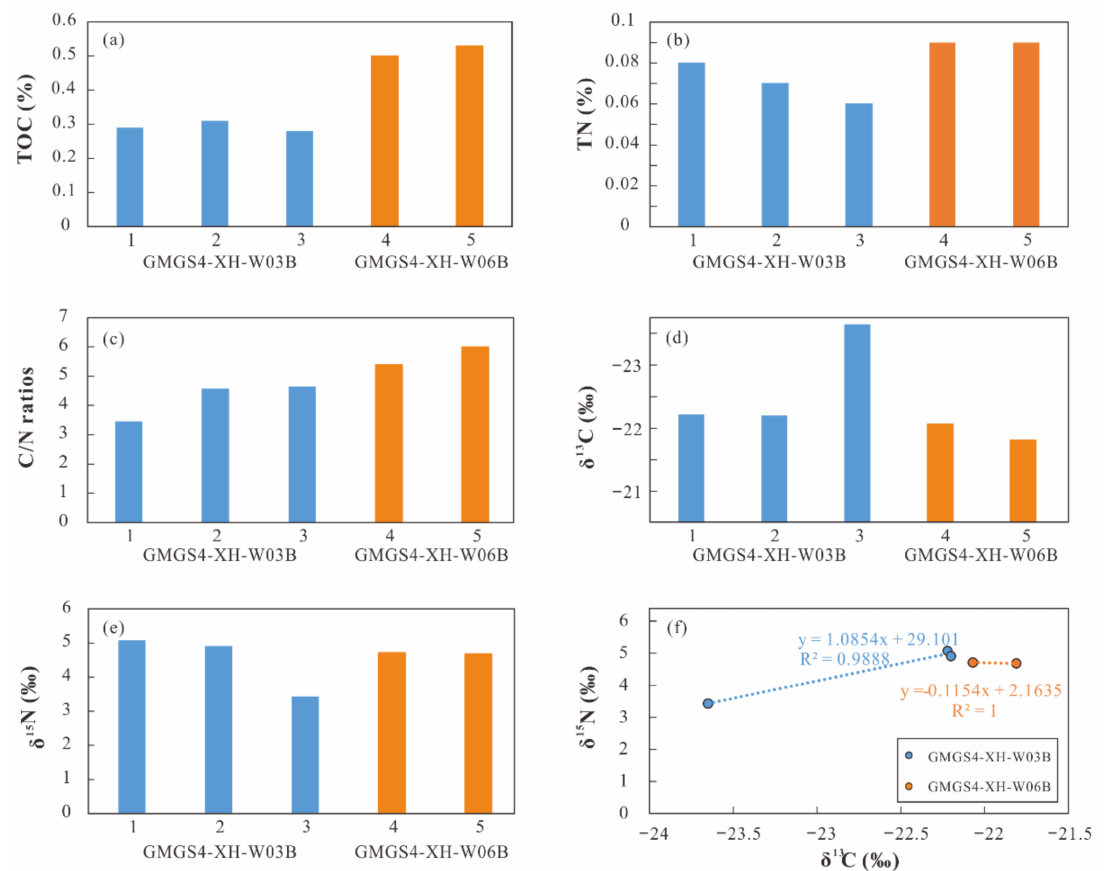
Figure 3. ( a ) TOC contents; ( b ) TN contents; ( c ) C/N ratios; ( d ) δ 13 C values; ( e ) δ 15 N values; and ( f ) cross-plot of the δ 13 C and δ 15 N values in